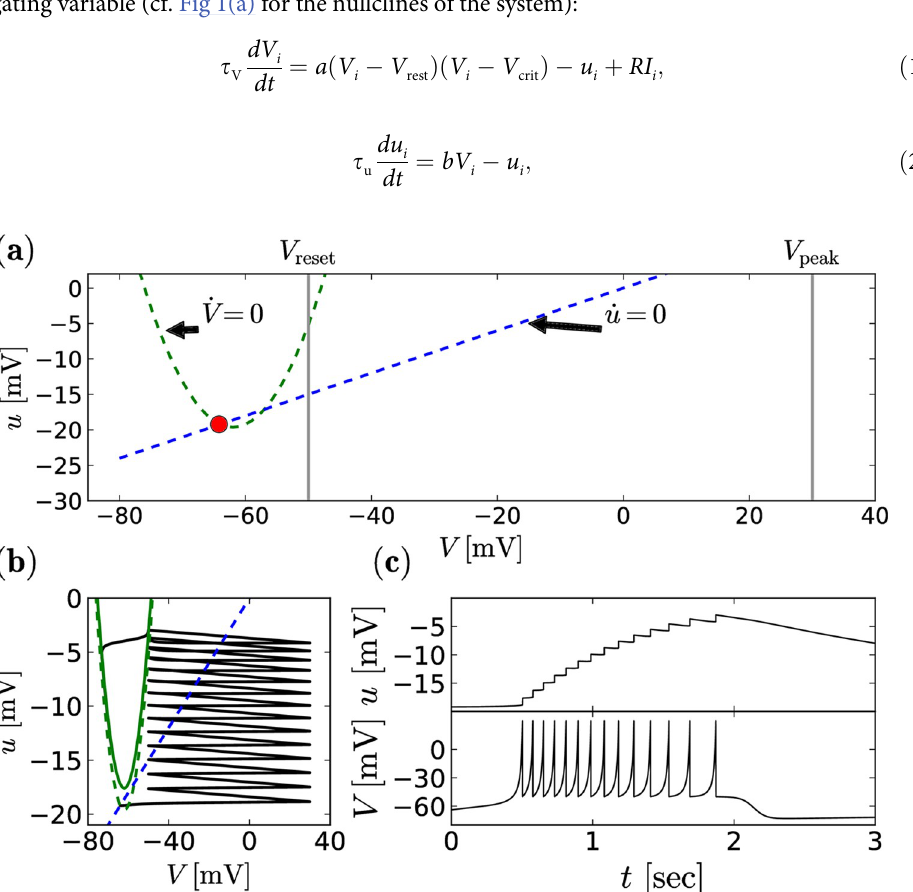
Fig 1. Burst mechanism of the single neuron model. (a) shows the nullclines of the Izhikevich neuron model in phase space ( V , u ) without current, RI = 0. The green dashed line shows the voltage nullcline and the blue dashed line shows the gating variable nullcline, respectively. Intersections of these two lines are fixed points of the system. The lower fixed point, indicated in red, is stable and represents the resting state of the neuron at ( V , u ) = ( V r , u r ) = ( − 64mV, − 19.4mV). The gray vertical lines indicate the peak voltage V peak and the reset voltage V reset . ( b ) shows the path in phase space of a neuron that is initially in the resting position, but exposed to an external current with RI = 2 mV from t = 0. The temporal evolution of the separate components u and V is illustrated in (c)